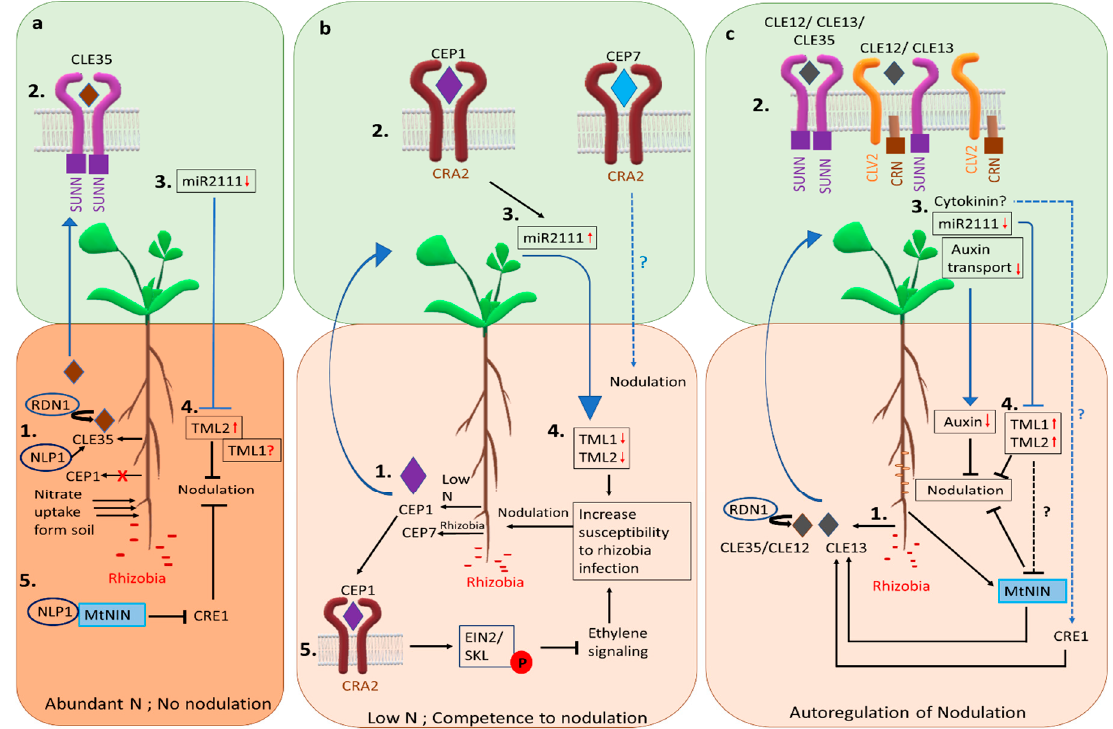
Figure 2. Mechanisms of controlling nodulation in M. truncatula . Under abundant soil N availability, plants take up nitrate from soil and do not form symbiotic nodules. ( a ) In response to nitrate (1), the expression of MtCLE35 is induced in the roots, dependent on the transcription factor MtNLP1. The small peptide MtCLE35 reduces nodule number systemically dependent on MtSUNN (2). This results in reduced expression of miR2111 in the shoot (3), releasing the repression of the MtTML2 transcript by miR2111 in the root (4). The reason for continued repression of MtTML1, which is also the target of miR2111, is not understood; whether MtTML1 is involved in nitrate control of nodulation is not clear (see text). Locally in the roots (5), MtNLP1 binds to MtNIN, inhibiting MtCRE1 expression to inhibit nodulation. ( b ) Under N limited conditions, the small peptide MtCEP1 is generated in the roots (1), which binds to the MtCRA2 receptor in the shoot (2), upregulating the expression of miR2111 in the shoot (3). Evidence suggests miR2111 is transported through the phloem to the roots, increasing the abundance of mature miR2111 in the roots. Mature miR2111 targets and lowers the transcript levels of MtTML1 and MtTML2 (4), increasing susceptibility to rhizobia and reducing AON. MtCEP1 activates MtCRA2 in the roots to phosphorylate MtEIN2, preventing its cleavage, thus repressing the ethylene response and promoting susceptibility to rhizobia (5). Another peptide, MtCEP7, generated in response to rhizobia, promotes nodulation dependent on the MtCRA2 receptor. ( c ) autoregulation of nodulation (AON). Rhizobial inoculation leading to nodule initiation results in the generation of MtCLE12 and MtCLE13 signaling peptides in the roots (1), which are transported in the xylem and bind to a shoot receptor complex containing MtSUNN, MtCRA2, and MtCRN (2). Together, the complex causes downregulation of miRNA2111 expression in the shoot (3). The result, perhaps through the transport of cytokinin as well as miRNA2111, is decreased miR2111 abundance in the roots and increased transcript levels of its targets MtTML1 and MtTML2 (4), inhibiting further nodulation. Another small peptide MtCLE35, which is also induced by high nitrate, controls the nodule number depending on MtRDN1 and MtSUNN in a similar manner as MtCLE12. MtNIN, involved in nodule organogenesis, also activates MtCLE13 expression to initiate AON. MtNIN might be under MtTML1 and MtTML2 regulation, maintaining a feedback control between nodule organogenesis and AON. Another potential shoot to root signal, cytokinin, may function through MtCRE1, which is required for MtCLE13 expression. Dashed lines represent proposed mechanisms; blue lines indicate systemic action and black lines indicate local events. All gene names in the figure are M. truncatula gene names, shown without the initial Mt for